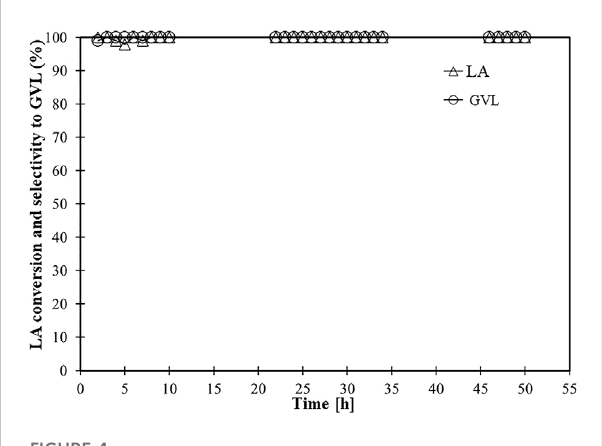
FIGURE 4 Time on stream activity ofMgO-UBE catalysts for theconversion of LA to GVL conversion reaction conditions: Catalyst-MgO-UBE, temperature-250 ° C, LA, FA weight ratio-1:2, liquid fl ow-0.015 mL/ min, N2 fl ow-25 cc/min, catalyst weight-0.5 g